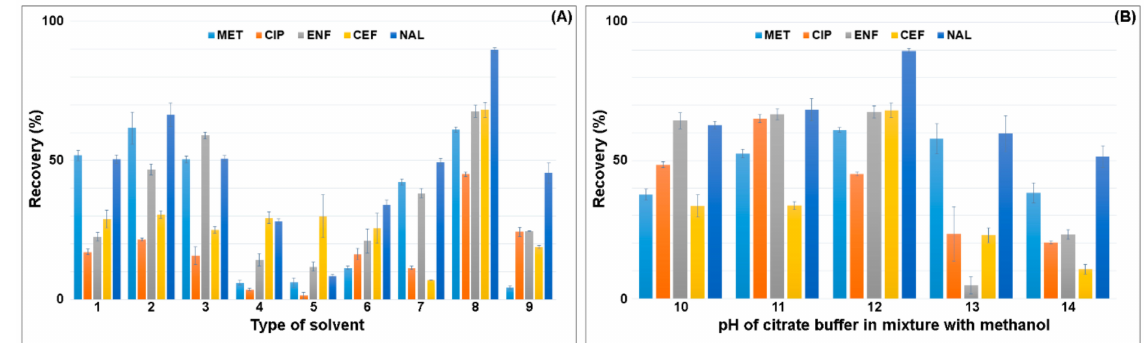
Figure 2. Effect of the ( A ) type of solvent on recovery of antimicrobials (1: methanol; 2: methanol:acetonitrile (1:1; v / v ); 3: methanol:0.1 M HCl (1:1; v / v ); 4: acetonitrile:acetone (1:1; v / v ); 5: acetonitrile:ethyl acetate (1:1; v / v ); 6: acetonitrile:0.01